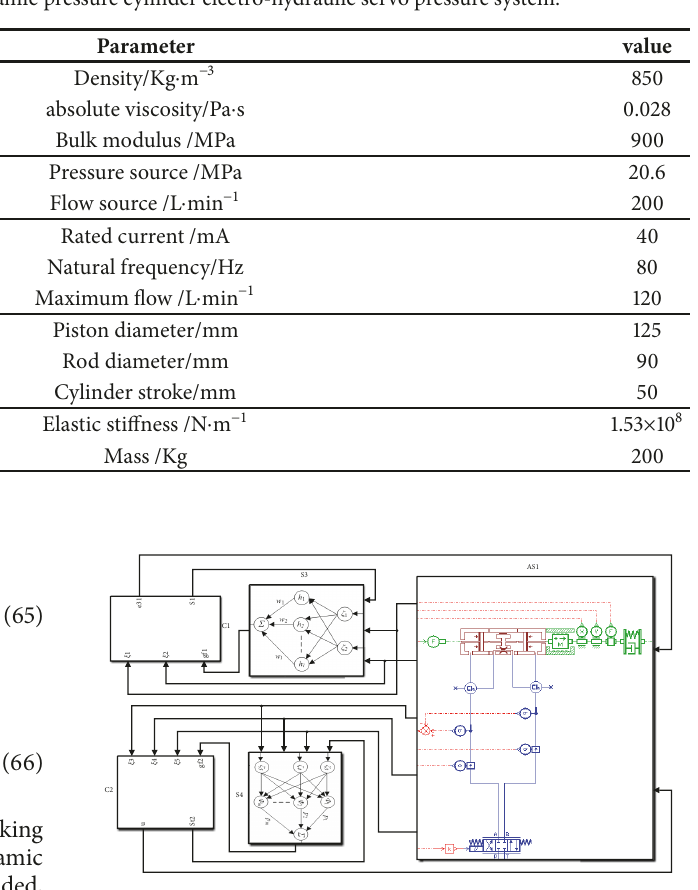
Figure 4: Dynamic pressure cylinder electrohydraulic servo pres- sure system RBF neural network backstepping sliding mode adap- tive control AMESim and Simulink cosimulation block